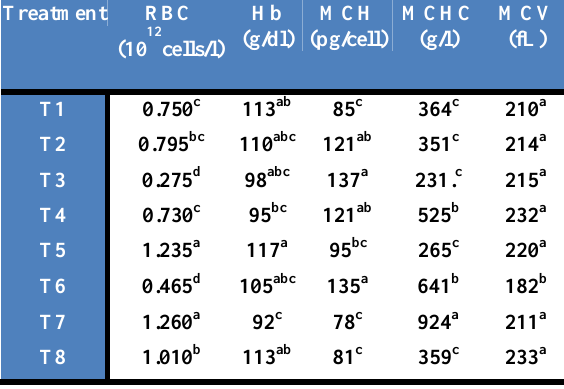
Table, 2: Effect of adding dry yeast, FOS and their combination in carp diet for 12 weeks on fish blood